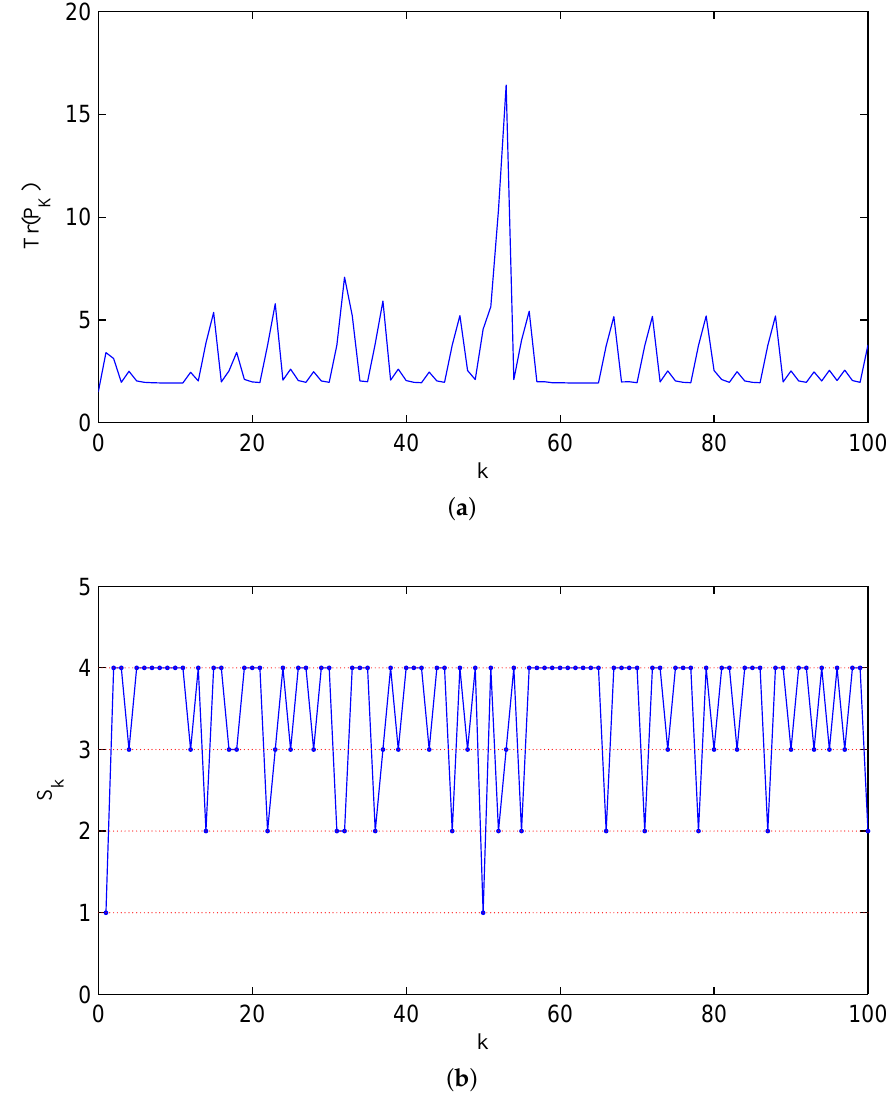
Figure 4. The error covariance matrix P k and channel state S k with ( q 1 , q 2 ) = ( 0.8, 0.9 ) : ( a ) The error covariance; ( b ) the associated channel